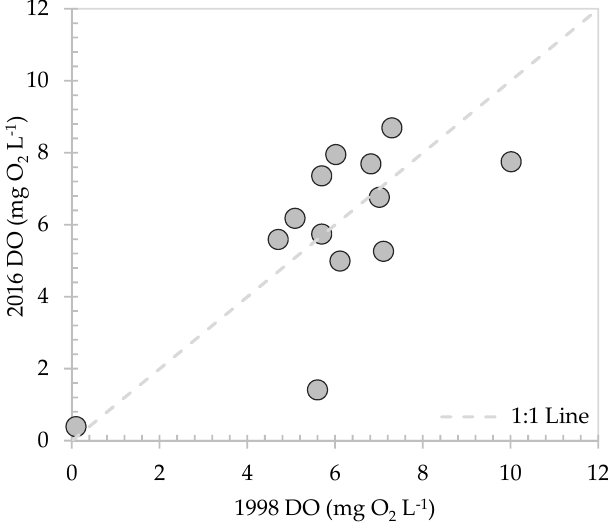
Figure A1. Comparison of groundwater dissolved oxygen (DO) in 2016 to 1998, where DO was mostly similar between both studies.